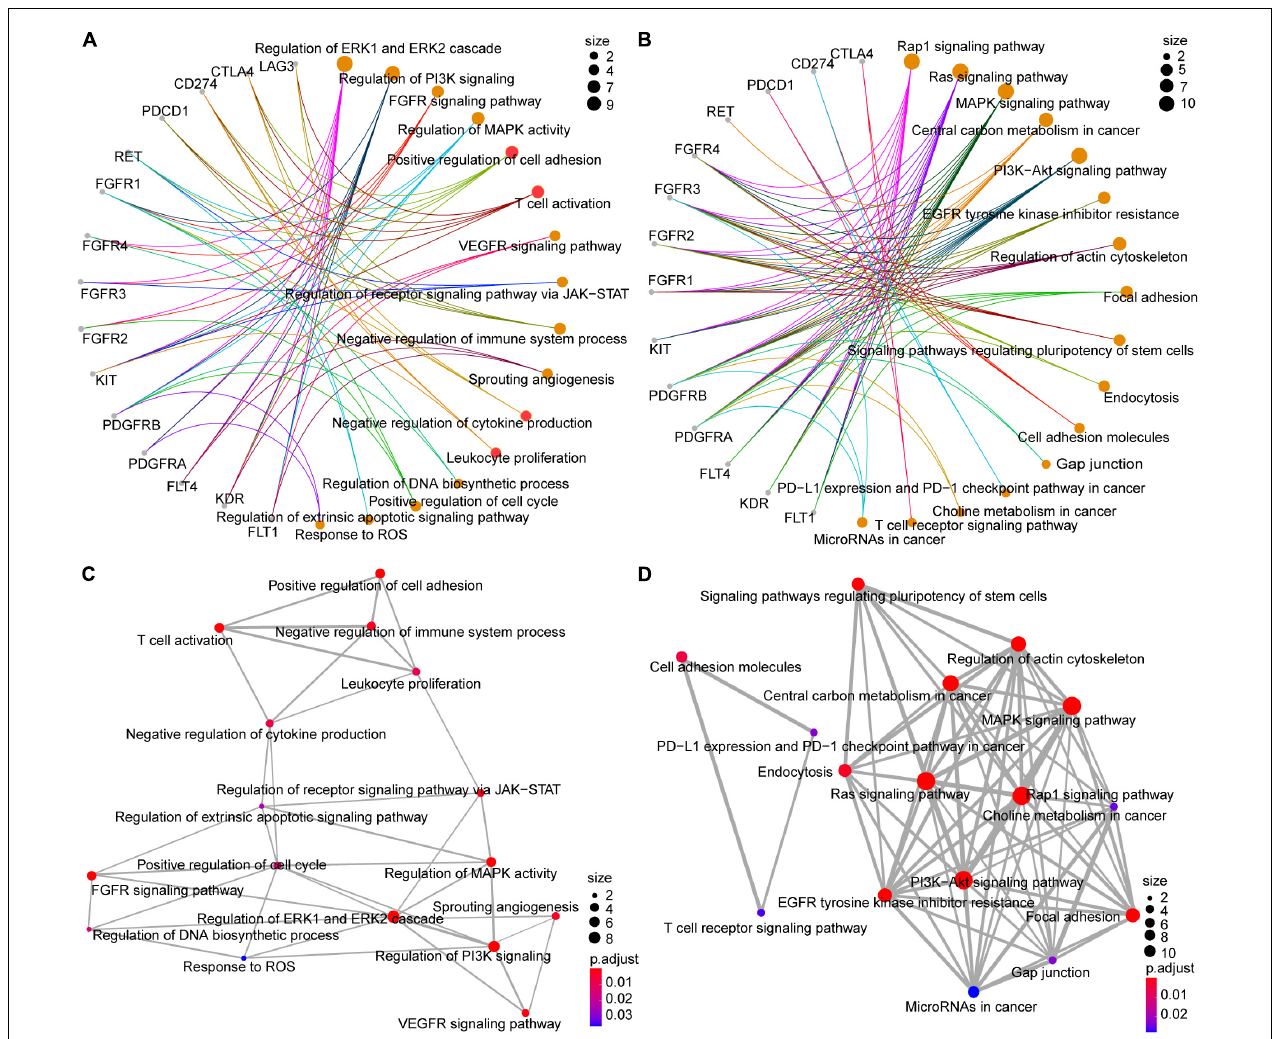
FIGURE 4 | GO and KEGG pathway analysis of lenvatinib and ICB target genes. (A,B) Network diagrams between GO terms (A) KEGG pathways (B) and target genes. (C,D) The emapplot of GO terms (C) and KEGG pathways (D) shown the “pathway–pathway” network. The color of the circle represents the adjusted P -value, and the size of the circle represents the number of enriched